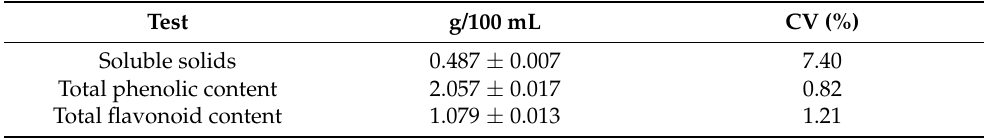
Table 1. CSEE a phytochemical